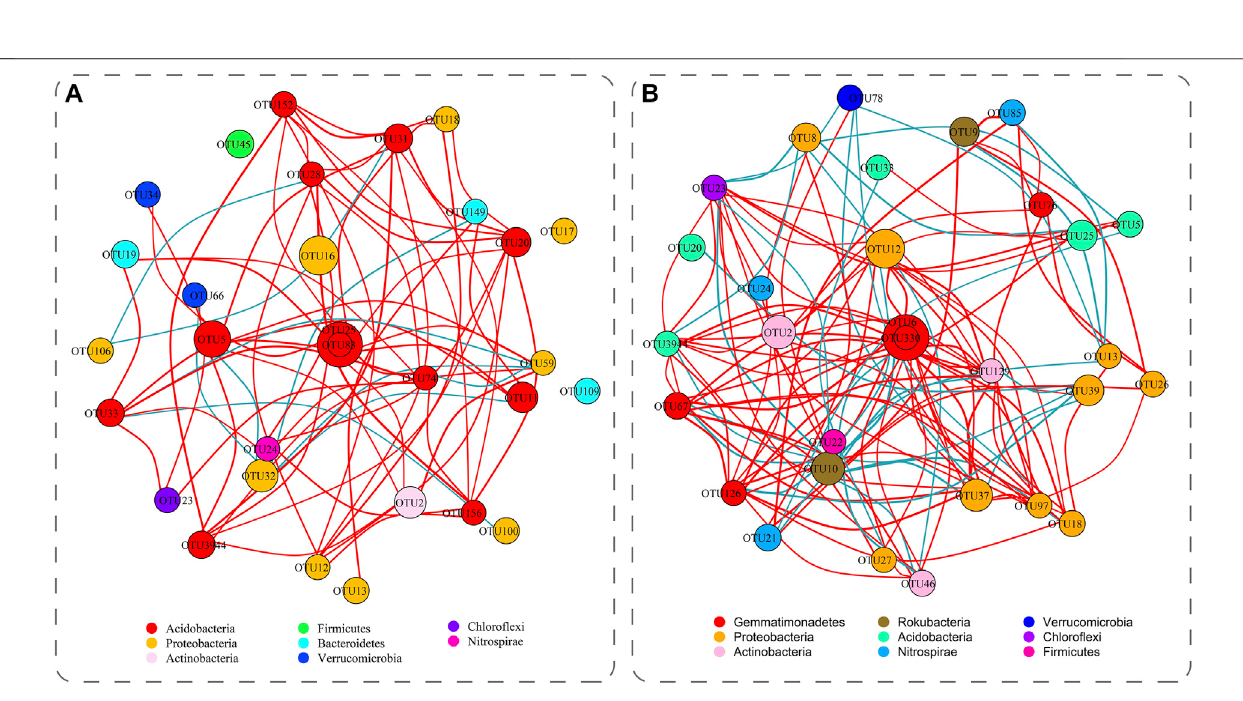
Frontiers in Environmental Science |